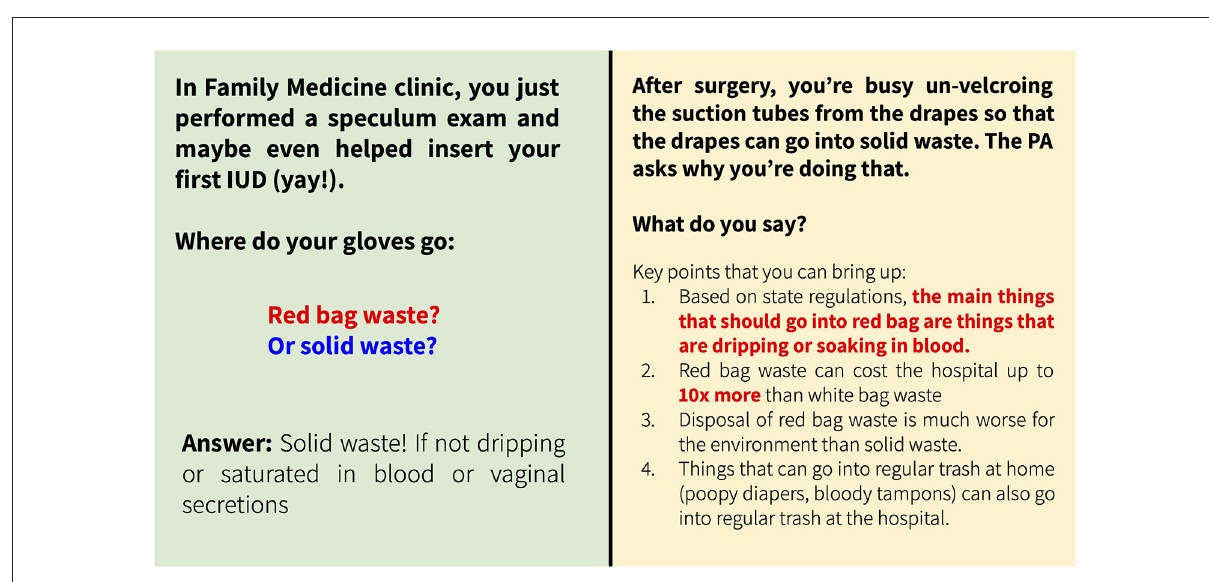
FIGURE3 Examples of practice scenarios from the waste disposal training delivered to all medical students entering